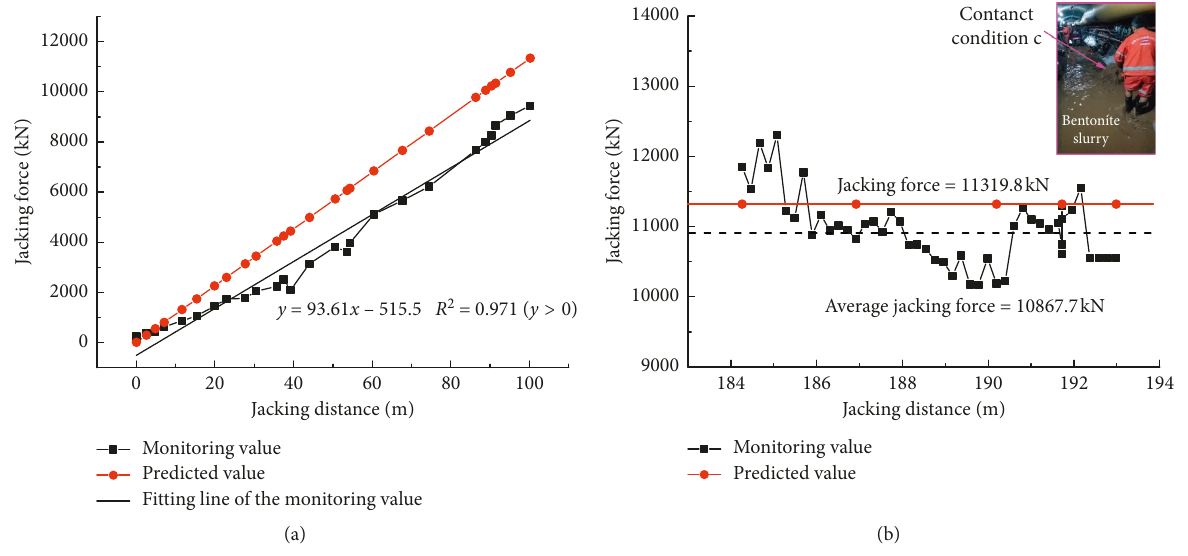
Figure 16: The comparison of jacking forces from monitoring and the empirical